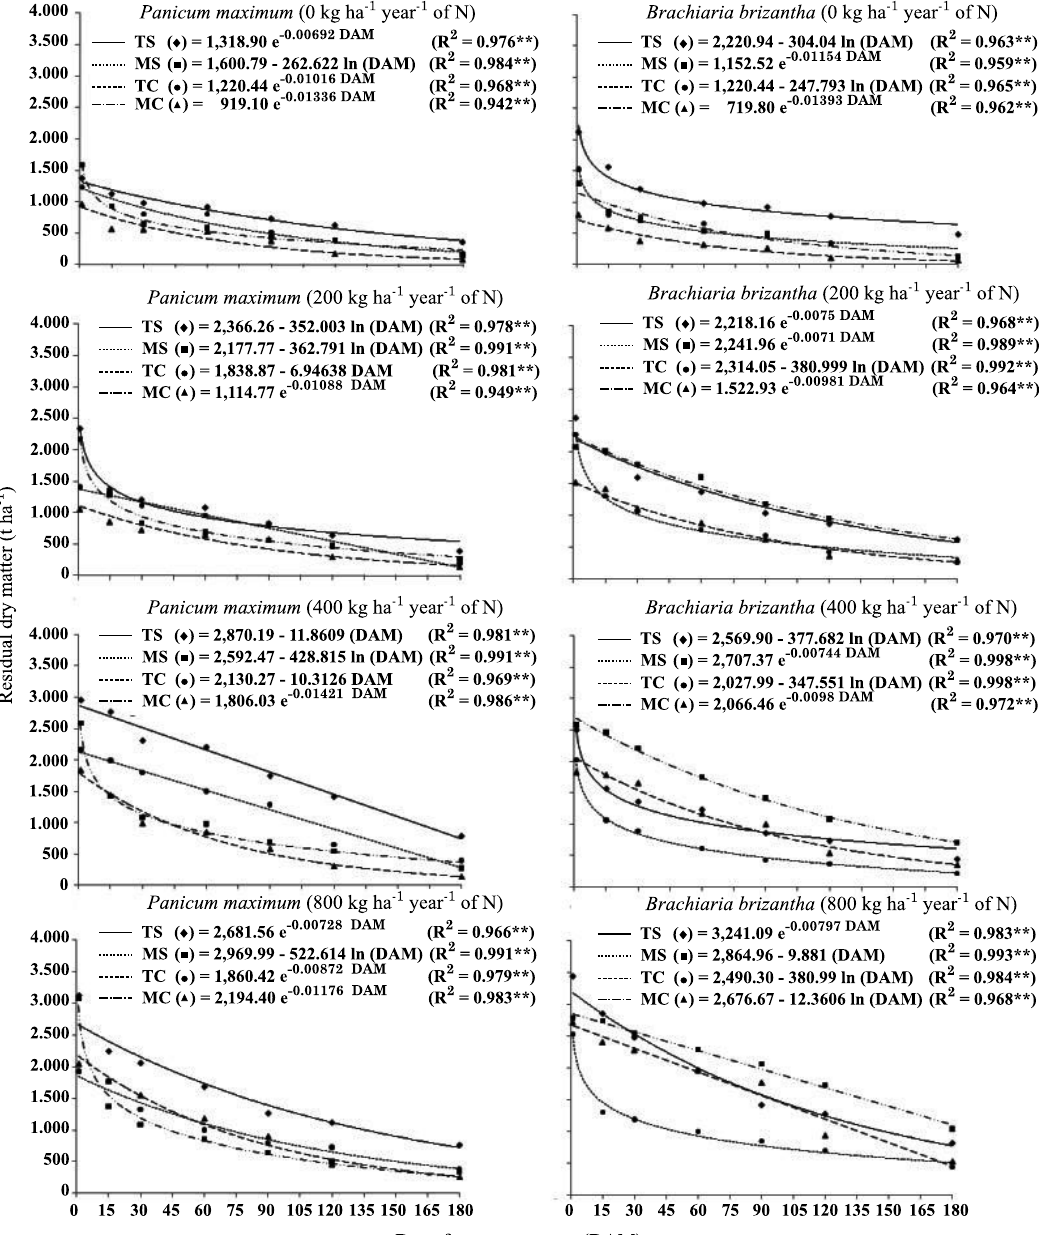
Figure 3. Straw decomposition (residual dry matter) of Panicum maximum cv. Tanzânia, P. maximum cv. Mombaça, Brachiaria brizantha cv. Marandu and B. ruziziensis grown intercropped with maize, N- fertilized (applied at four cuts) and chopped after the last cut in winter/spring. TS, MS, BS and RS: Panicum maximum cv. Tanzânia, P, maximum cv. Mombaça, Brachiaria brizantha cv. Marandu and B. ruziziensis sown together with maize, respectively; TC, MC, BC and RC: Panicum maximum cv. Tanzânia, Panicum maximum cv. Mombaça, Brachiaria brizantha cv. Marandu and Brachiaria ruziziensis sown at the time of N side dressing of maize, respectively. ** : (p <